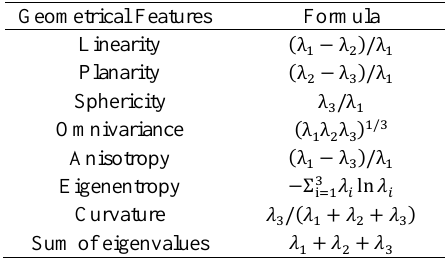
Table 1. Local geometrical